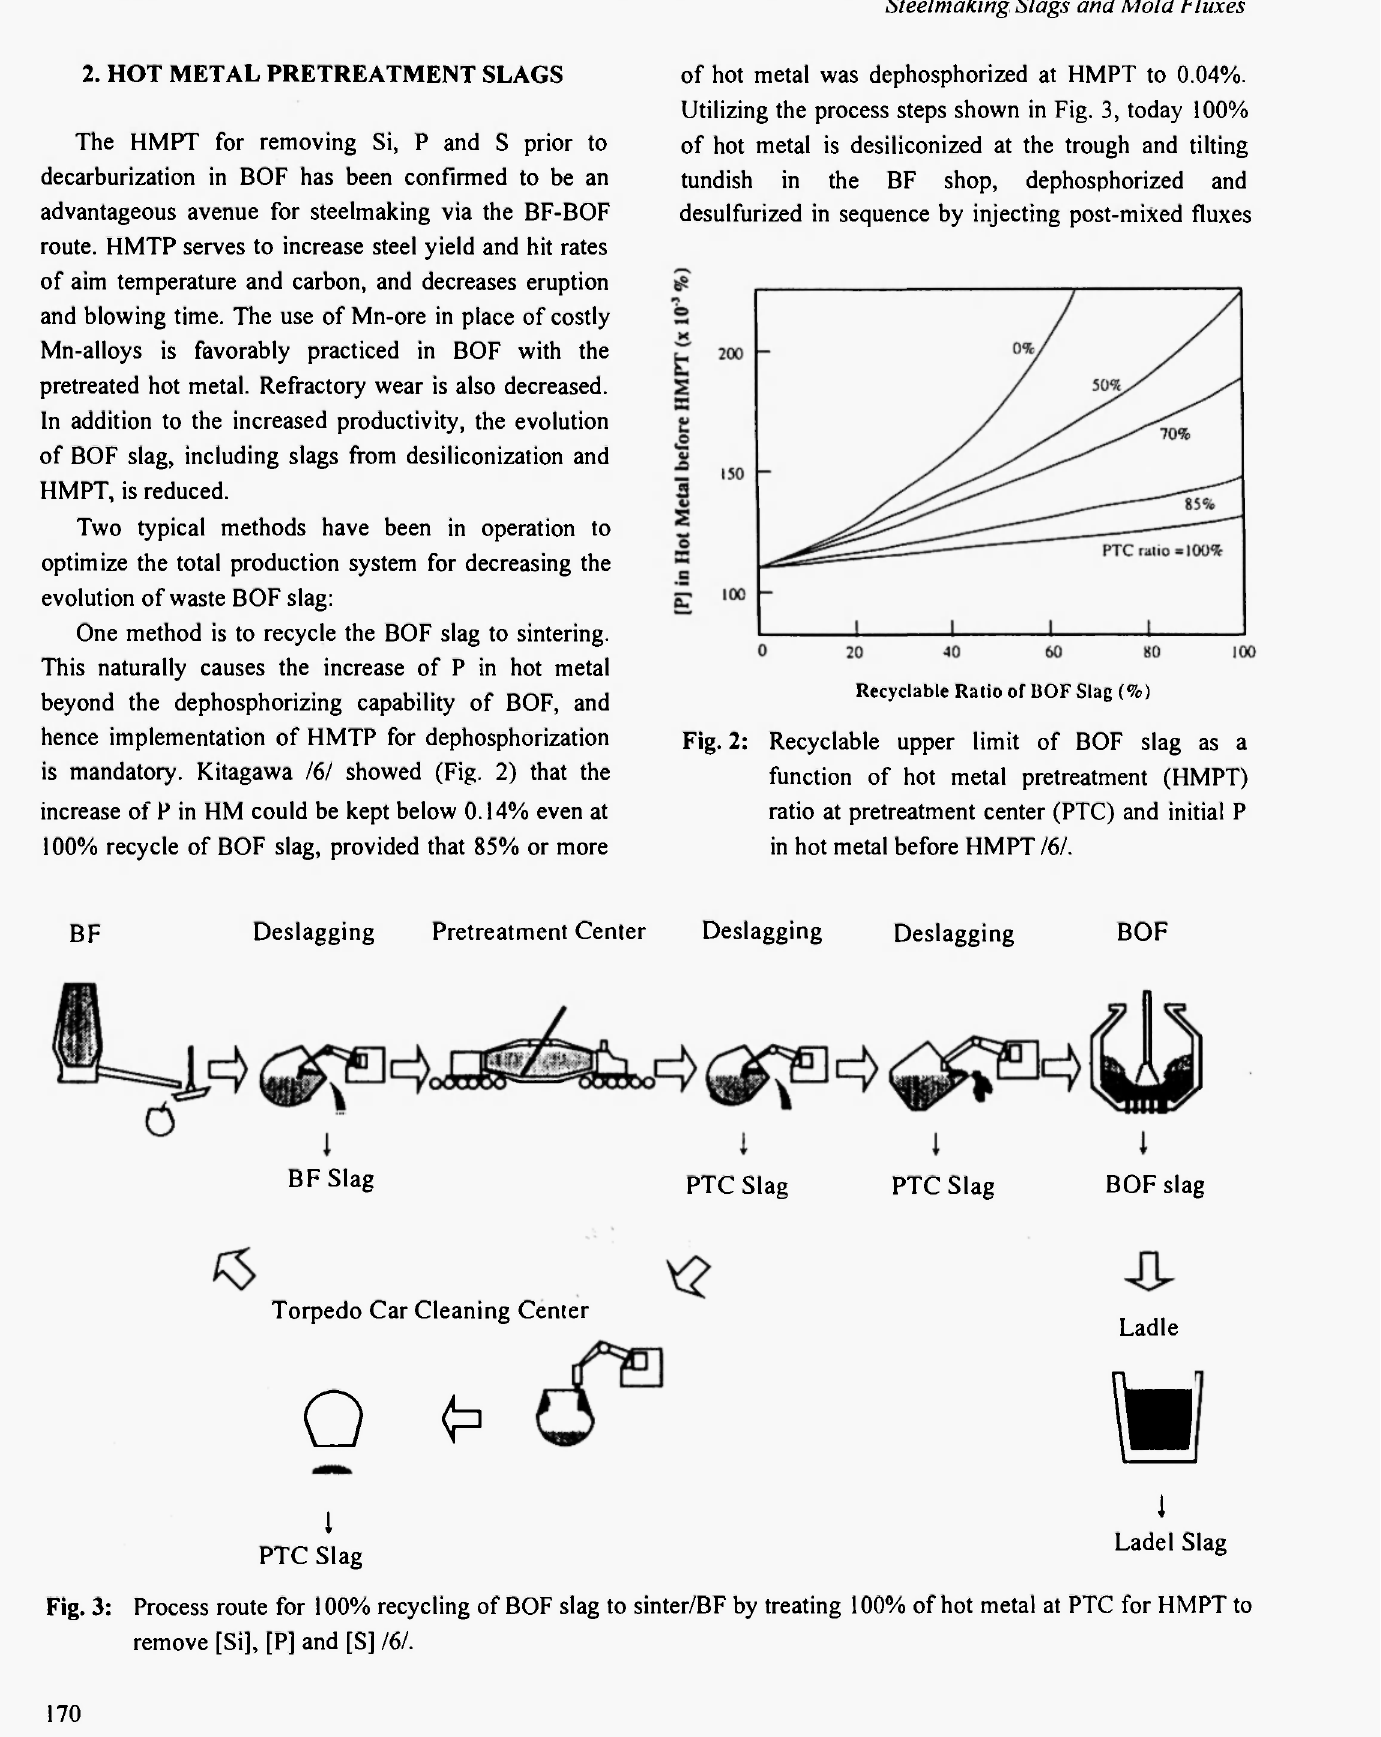
Fig. 3: Process route for 100% recycling of BOF slag to sinter/BF by treating 100% of hot metal at PTC for HMPT to remove [Si], [P] and [S]